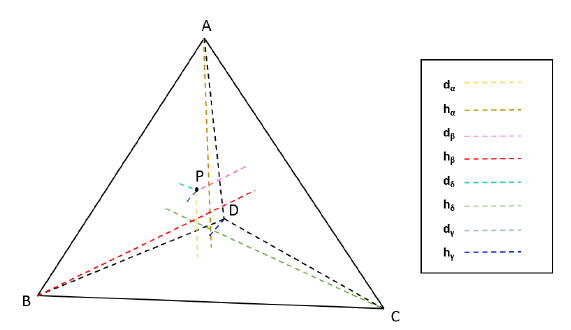
Figure 2. The new coordinates system using scaled point-to-plane